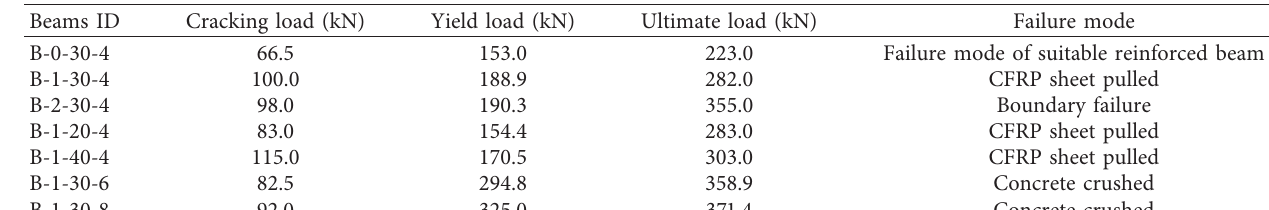
Figure 3: Layout of test measuring equipment (unit: mm). Table 4: Main test results of the specimen.